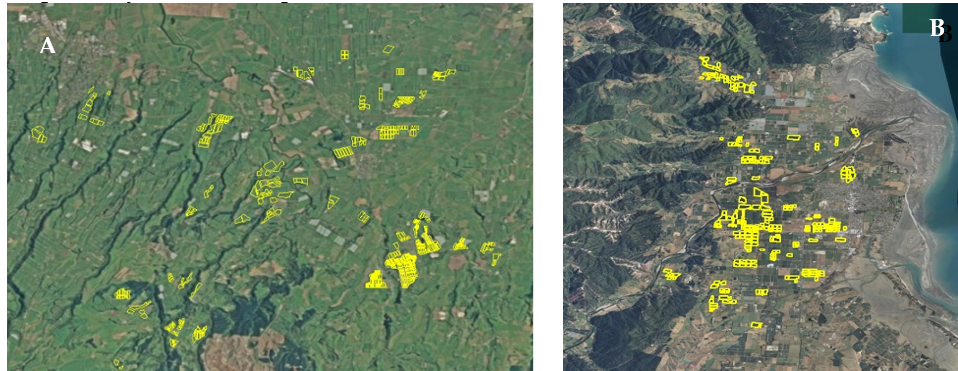
Figure 3. Infected and not-infected digitalized blocks in the Te Puke region ( A ) and in the Takaka region (New Zealand) ( B ).